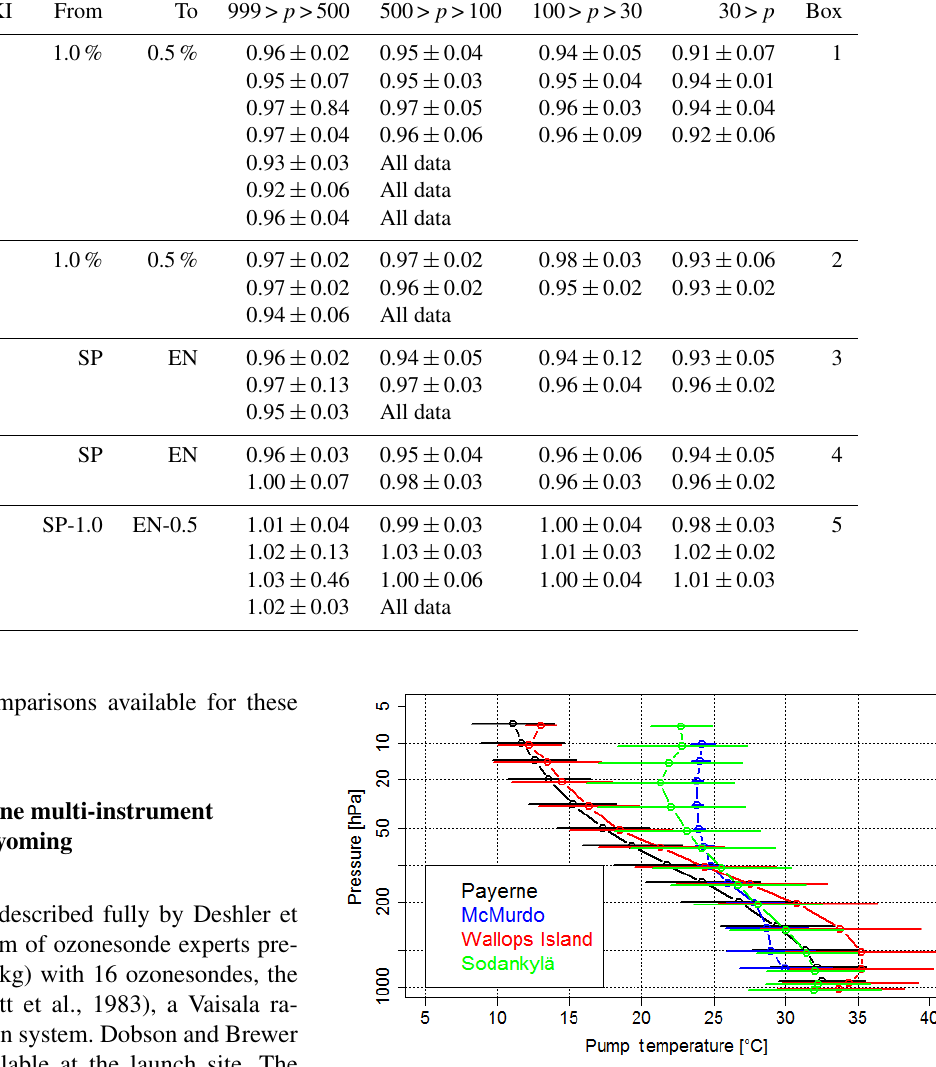
Figure 3. Mean profile of the measured pump temperature for the different dual-ozonesonde flight data sets. The higher pump tem- perature at the upper part of the profiles for the McMurdo and So- dankylä stations is due to a heat source to avoid freezing of the solution. Error bars are 1 standard deviation of the